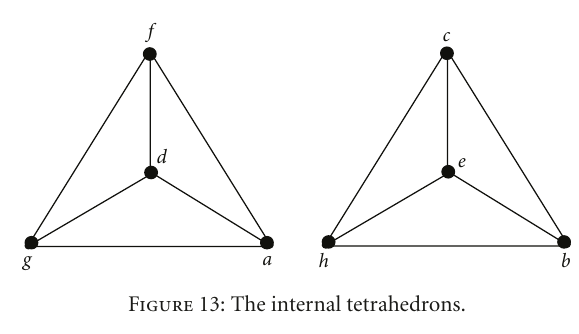
Figure 13: The internal tetrahedrons.